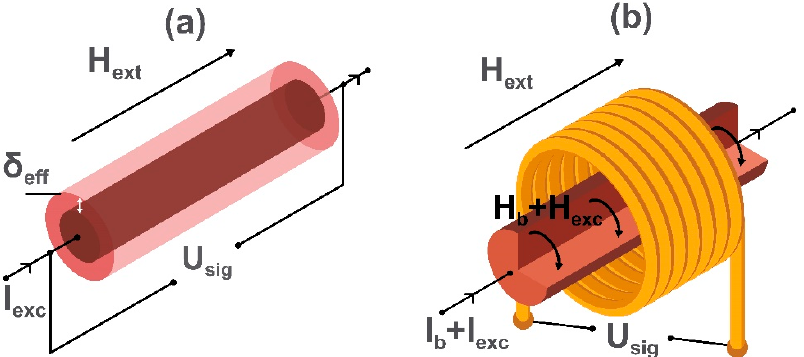
Figure 7. Schematic images of the conventional GMI ( a ) and o ff -diagonal GMI ( b ) magnetic field sensing elements, where H ext is the dc external magnetic field (measured field), I exc and H exc are the ac excitation current and field, I b and H b are the dc bias current and field, respectively, U sig is the measured output voltage, and δ e ff is the skin depth of the electric current in the element. The circular bias field H b is needed in the case of the o ff -diagonal GMI to eliminate the domain walls in the circular domain